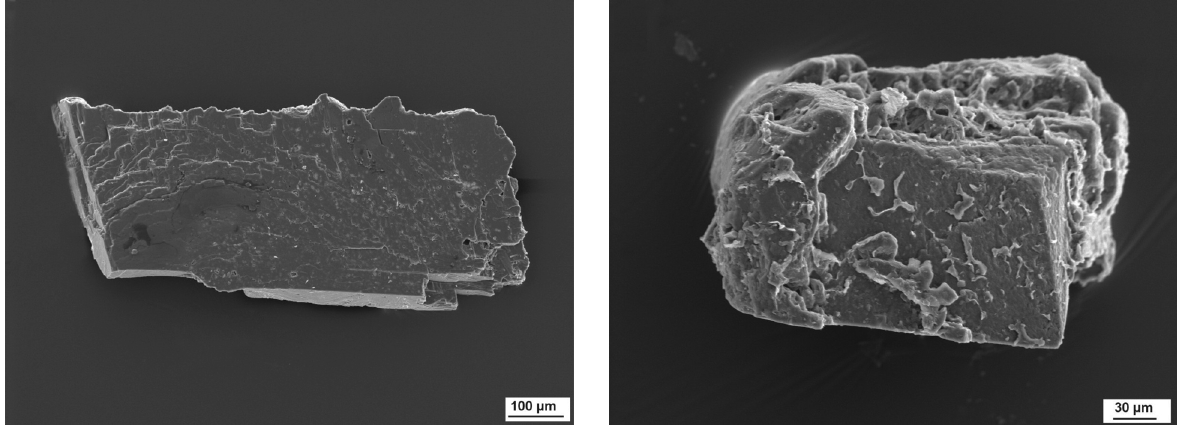
Fig. 13. Void-filling dolomite crystals in the Upper Pskov unit in scanning electron microscopy (backscattered electron imaging mode). Tsiistre drill core, 47.2 m, GIT